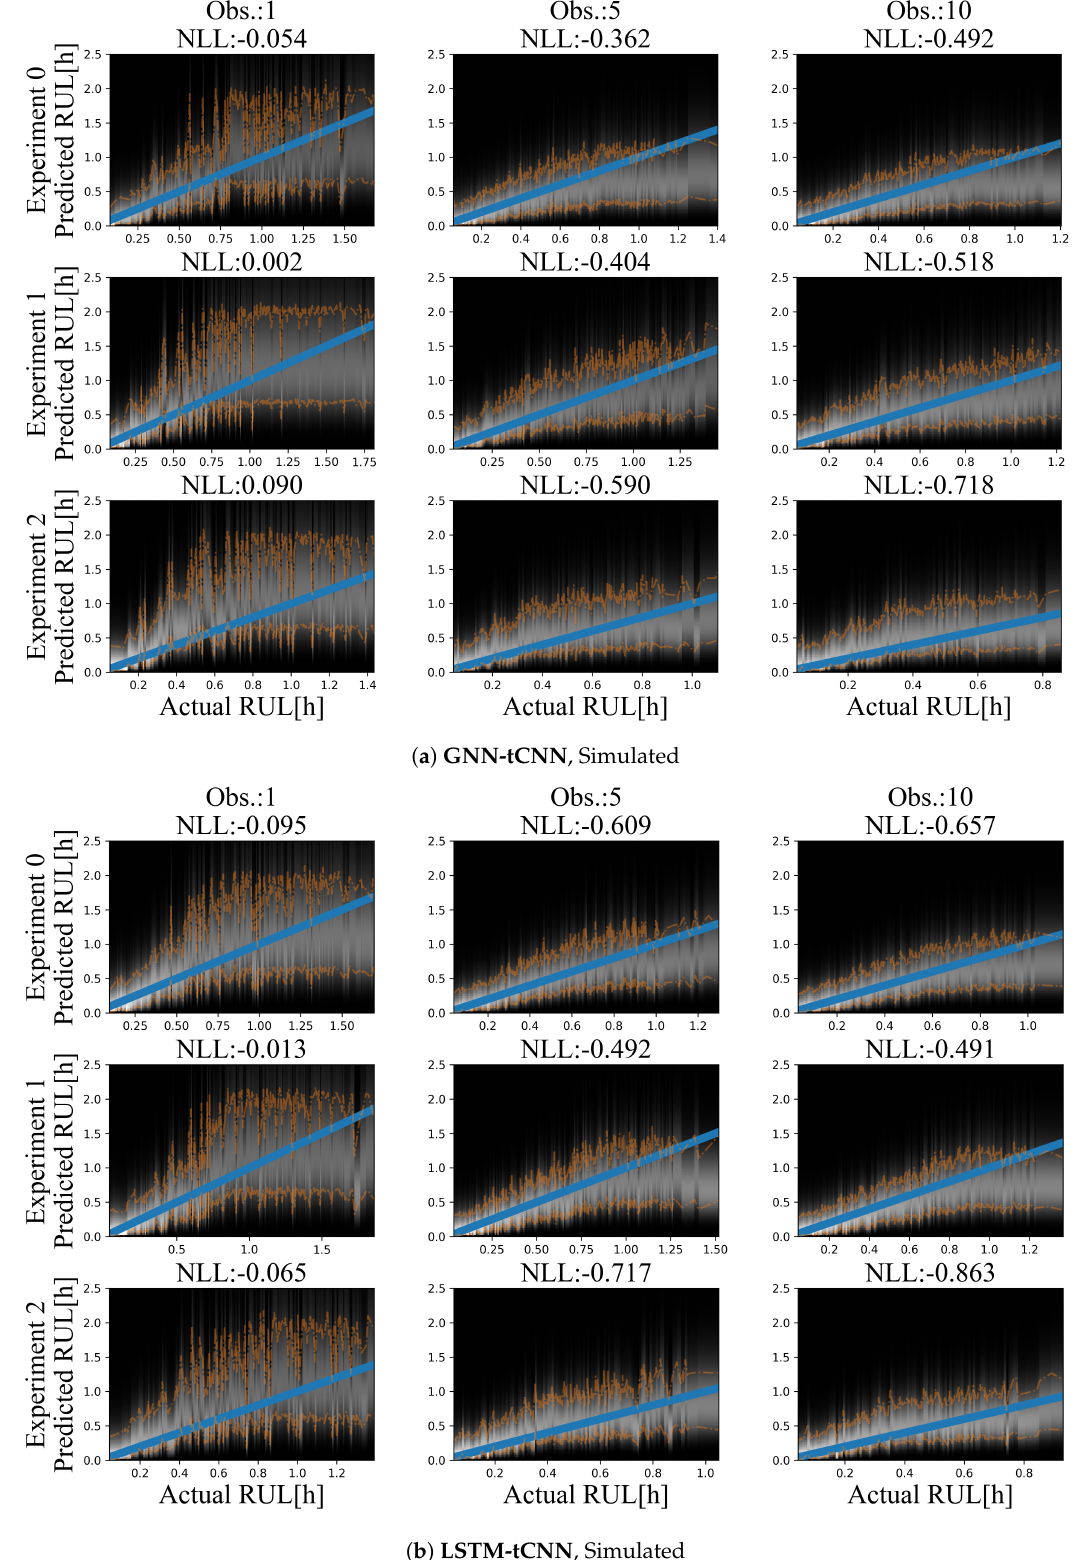
Figure 9. Results on the simulated dataset using ( a ) GNN-tCNN (top) and ( b ) LSTM-tCNN (bottom). The blue line corresponds to the correct prediction assuming constant linear degradation. The orange lines correspond to the 10% and 90% quantiles of the